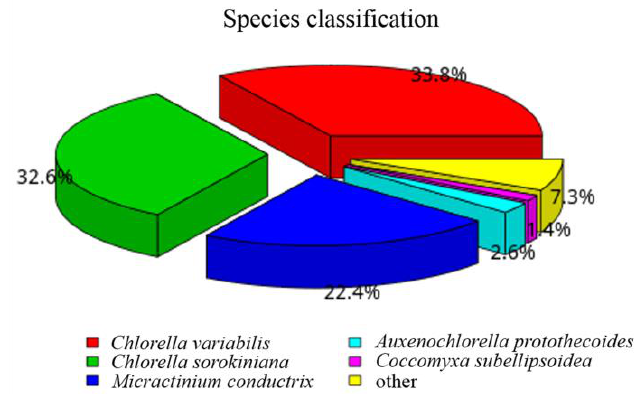
Figure 9. Species diagram of P. kessleri FACHB-3316 in NR database annotation.